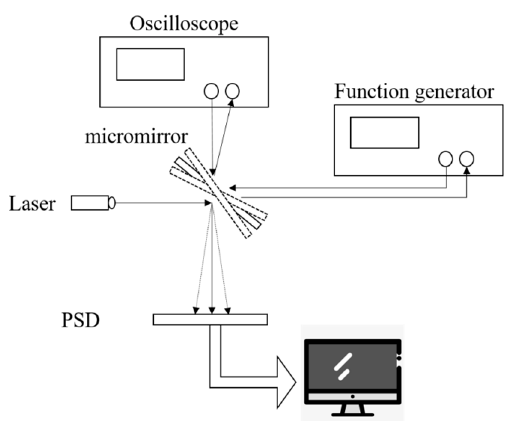
Figure 8. Schematic measurement setup: the 2-Dscanning mirror was driven independently by function generators [31].